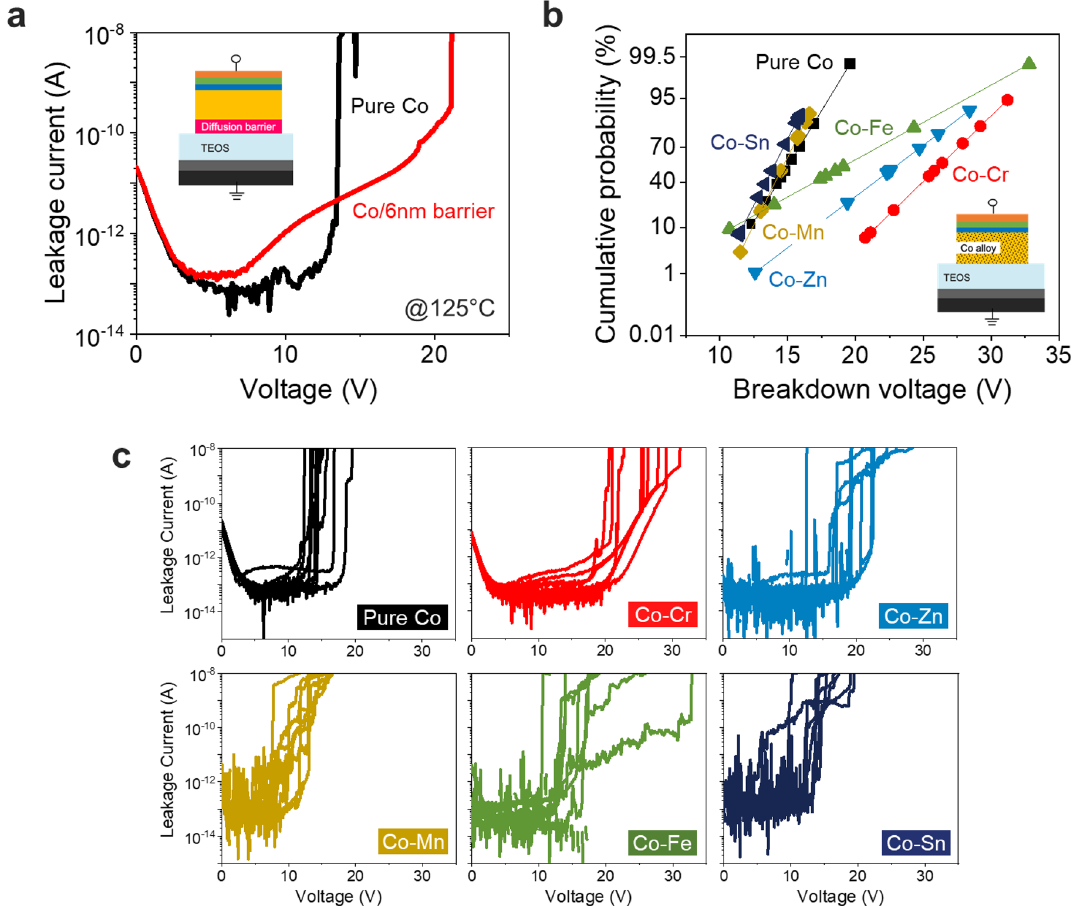
Figure 3. Voltage ramped dielectric breakdown (VRDB) analysis of pure Co and Co alloy MIS structures. ( a ) diffusion barrier effect; the leakage current shape is different for pure Co and Co/6 nm barriers. this is because the current conduction mechanism varies depending on the metal filament formation behavior. ( b ) cumulative distribution function (CDF) plot of breakdown voltage of pure Co and Co alloys. ( c ) I–V characteristics of pure Co and Co alloys after annealing at 450 °C. Electrical failure (breakdown voltage) was defined when leakage current increased over 10 –8 A. Breakdown voltage values of the x-axis were converted to breakdown electric field values in Fig.